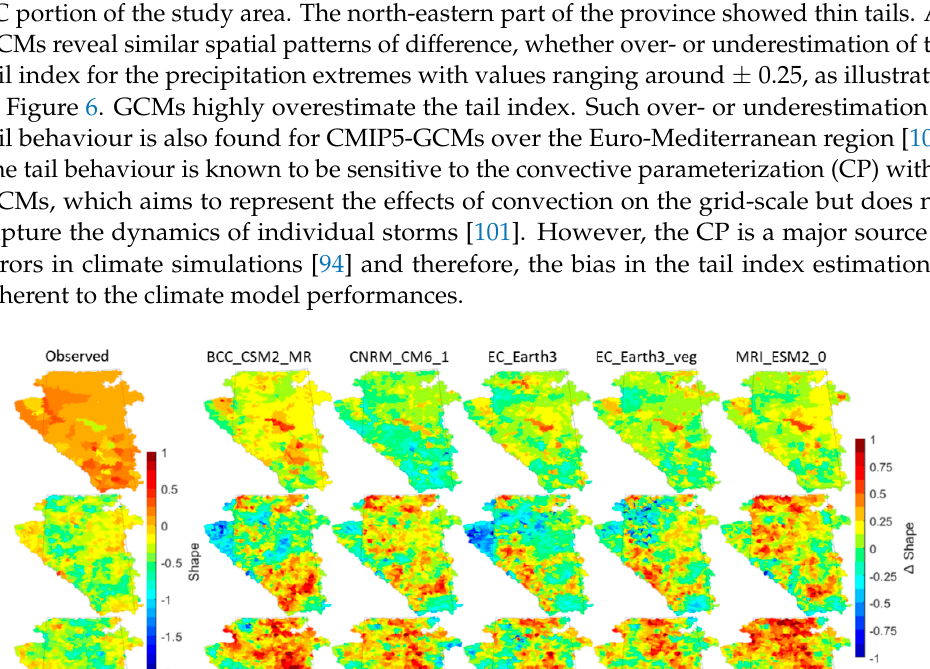
Figure 8. Kernel density curves of the tail index (shape parameter) of P, Tmax, and Tmin extremes for the 1983–2014 period. 4.6. Regional Variation of GCM Performances In this section, we discuss GCMs’ performances in reproducing the extremes of P, Tmax, and Tmin in the four identified regions within Alberta Figure 1. 4.6.1. Extreme Characteristics The regional distributions of density curves (Figure 9) show fluctuation in densities of mean duration and frequency of CWD, SD, and WN. The shape of the distribution var- ies across regions. The western mountainous region (R1) has flat shaped density curves with reduced peaks for both duration and frequency. R2, which consists of grassland with